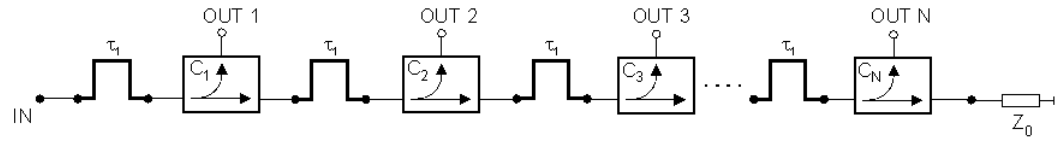
Figure 3. General scheme of an analogue tapped cascaded delay line.